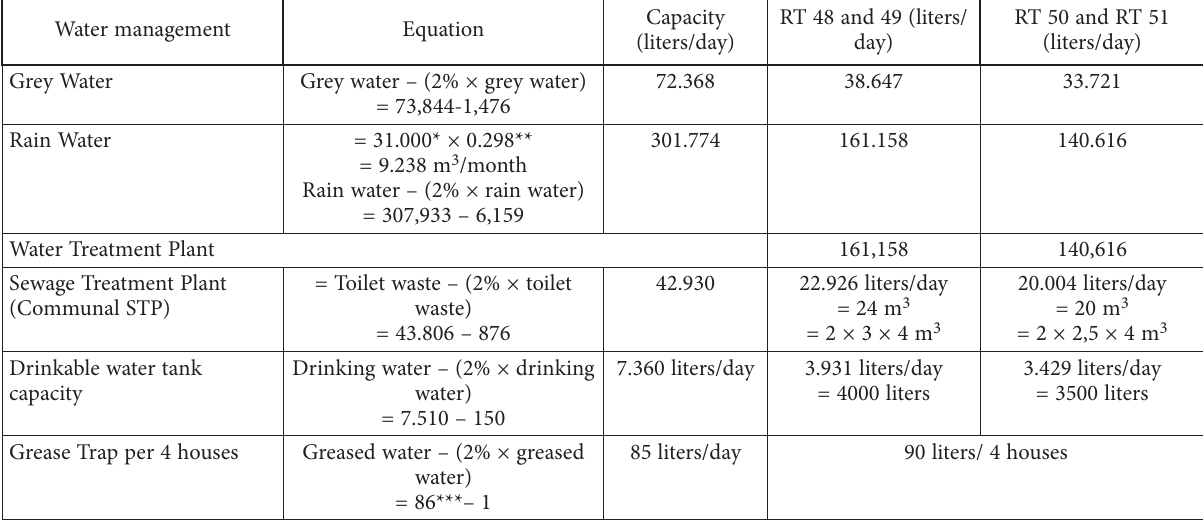
Table 9. Water management system of Kampong